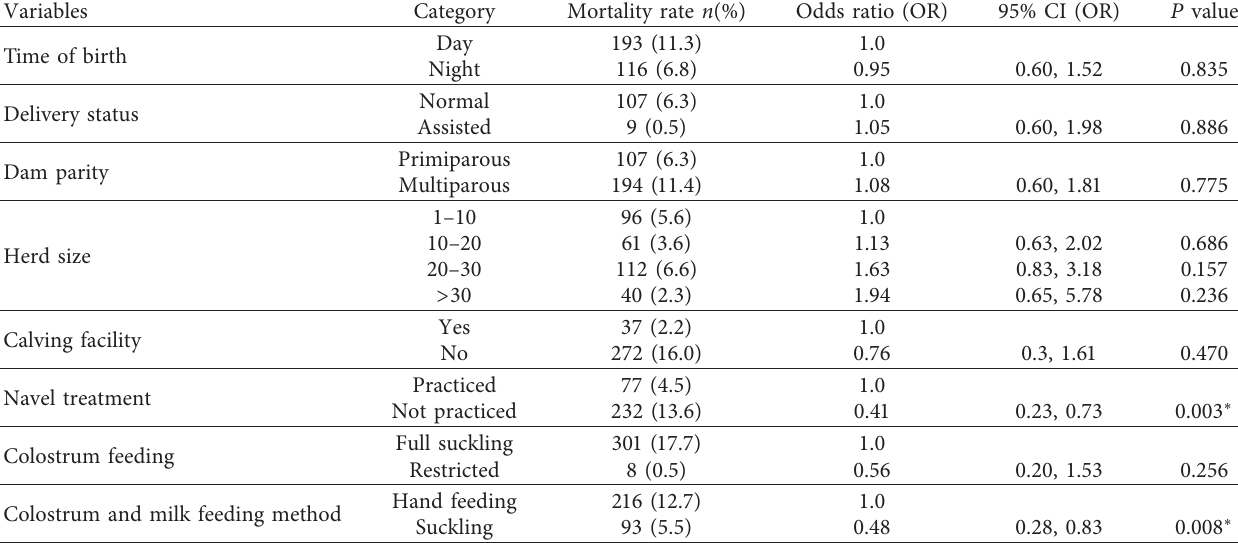
Table 4: Logistic regression analysis of management-related risk factors for mortality of calves in the dairy production system.